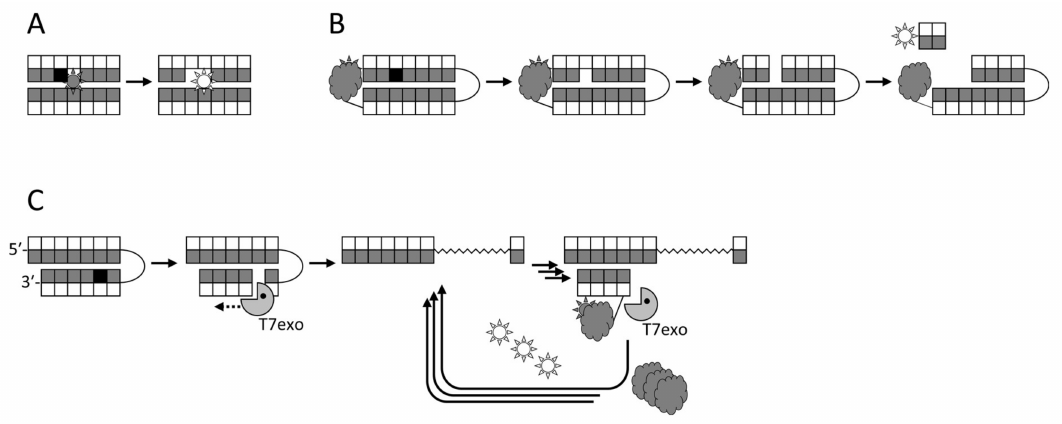
Figure 2. Schemes of several fluorescence-based approaches to DNA glycosylase detection. ( A ), fluorescent reporters adjacent to the lesion; ( B ), molecular beacons with a fluorophore–quencher pair; ( C ), T7 exonuclease-assisted signal amplification due to cyclic degradation of a probe bearing a fluorophore–quencher